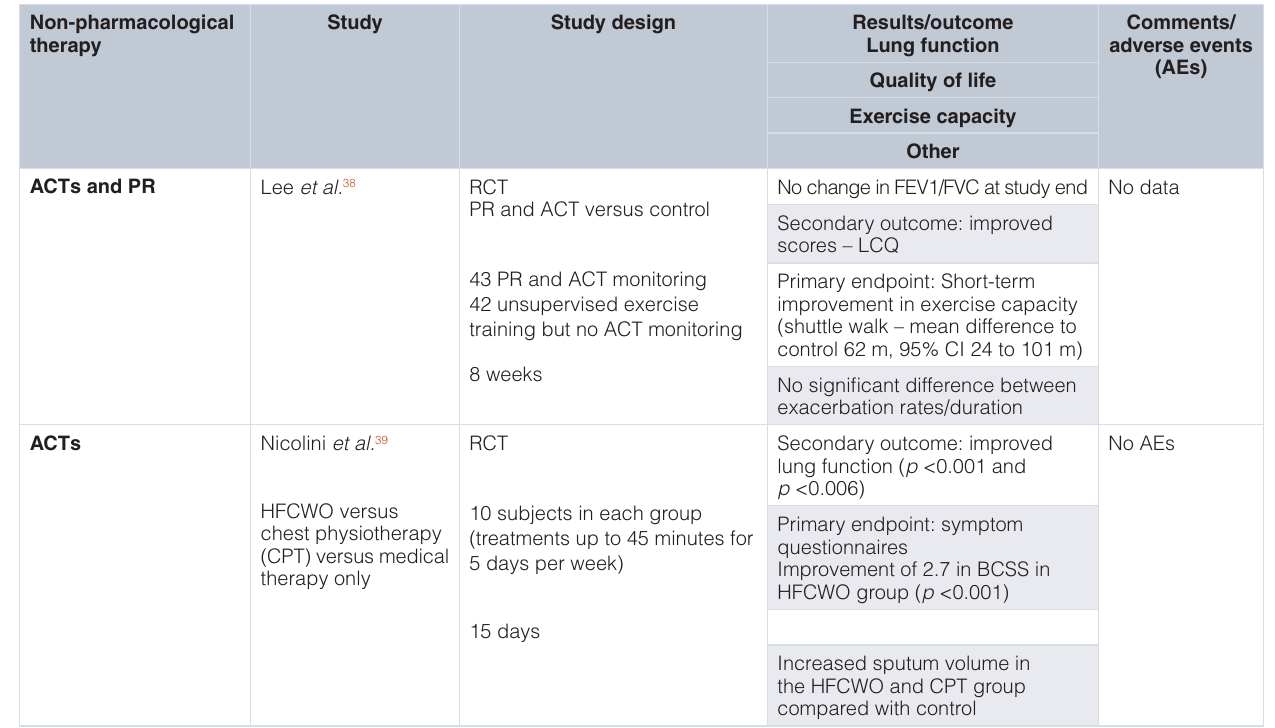
Table 1. Summary of randomised controlled trials (RCTs) for airway clearance techniques